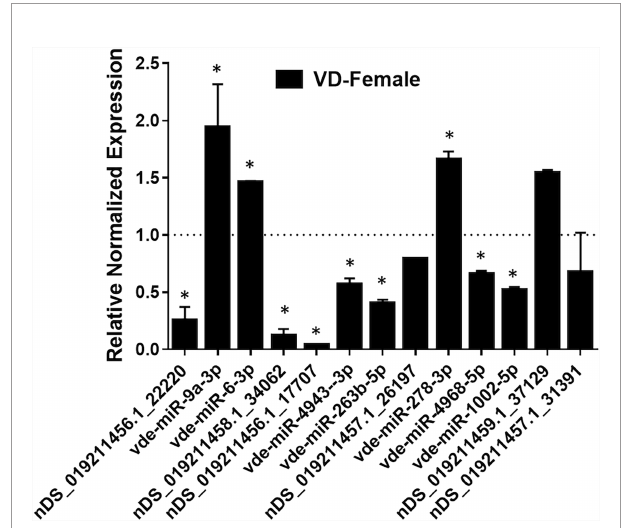
FIGURE 7 | qPCR validation of selected mature miRNAs (high con fi dence) in female Varroa differentially expressed relative to male Varroa . Statistical signi fi cance for qRT-PCR-based differential expression was determined by the 2-tailed Student ’ s t -test, where * denotes p <0.05. miRNA expression of female Varroa was normalized to that of male Varroa (indicated as 1 on y- axis). Succinate dehydrogenase ( SDHA ) was used as a housekeeping control.